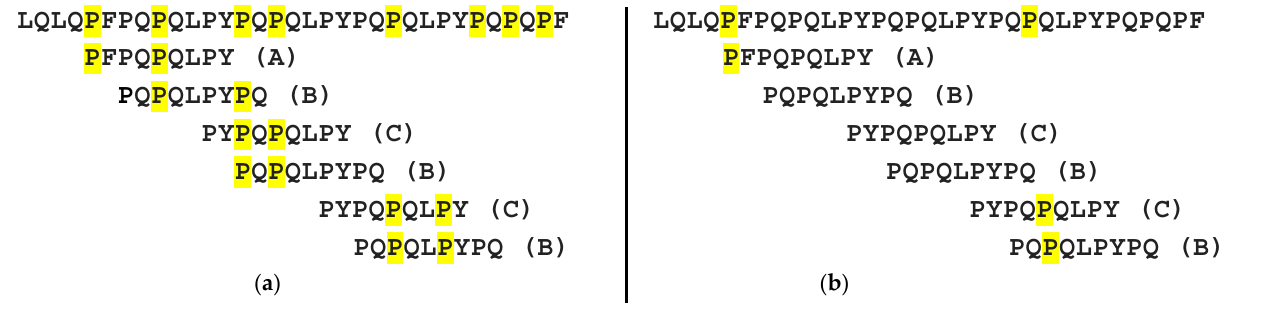
Figure 3. The 33-mer peptide from α -gliadin (first line). Cleavage sites of the FvpP ( a ) and An-Pep ( b ) are marked in yellow. Further lines depict the three T-cell epitopes (A, B and C) presumed to elicit immune reactions leading to CD and the corresponding cleavage sites.